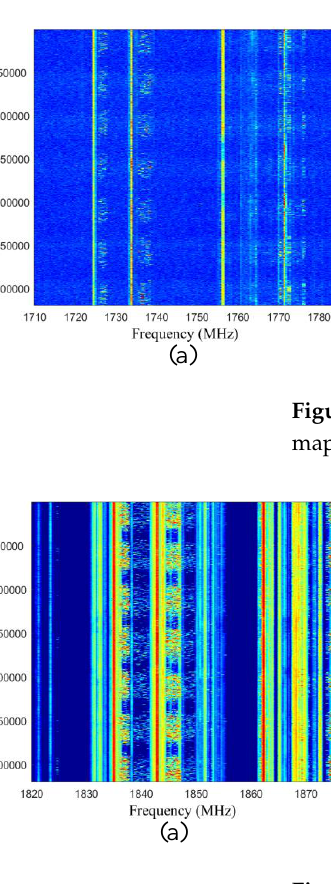
Figure 2. Periodic analysis of GSM1800 Downlink: ( a ) Raw spectrogram ( b ) Temporal-correlation heat map ( c ) Data